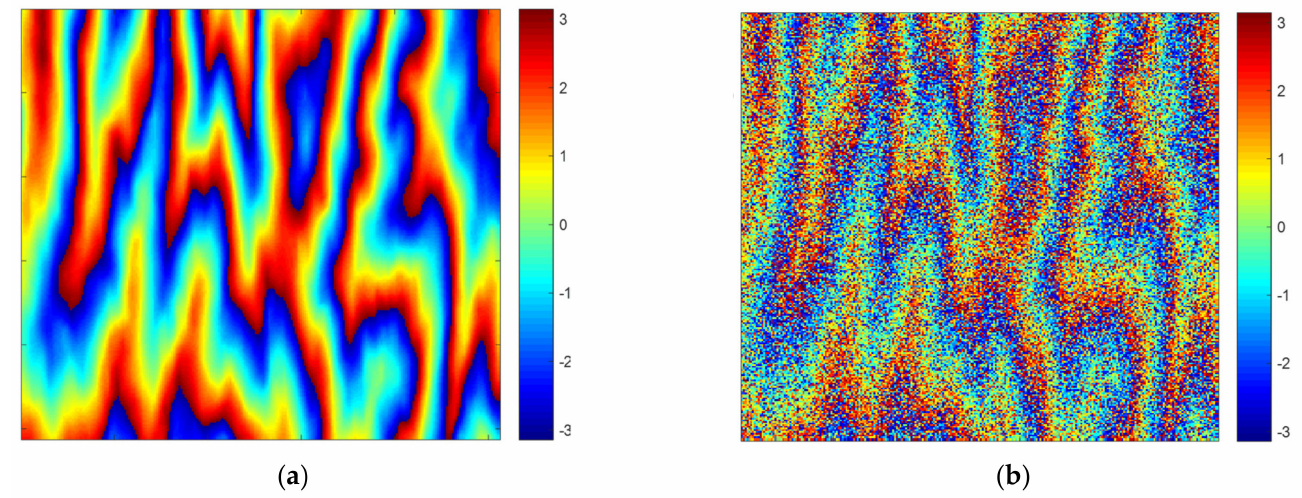
Figure 6. A simulated testing interferogram patch: ( a ) Clean interferogram patch; ( b ) noisy interfero- gram patch with a coherence coefficient of